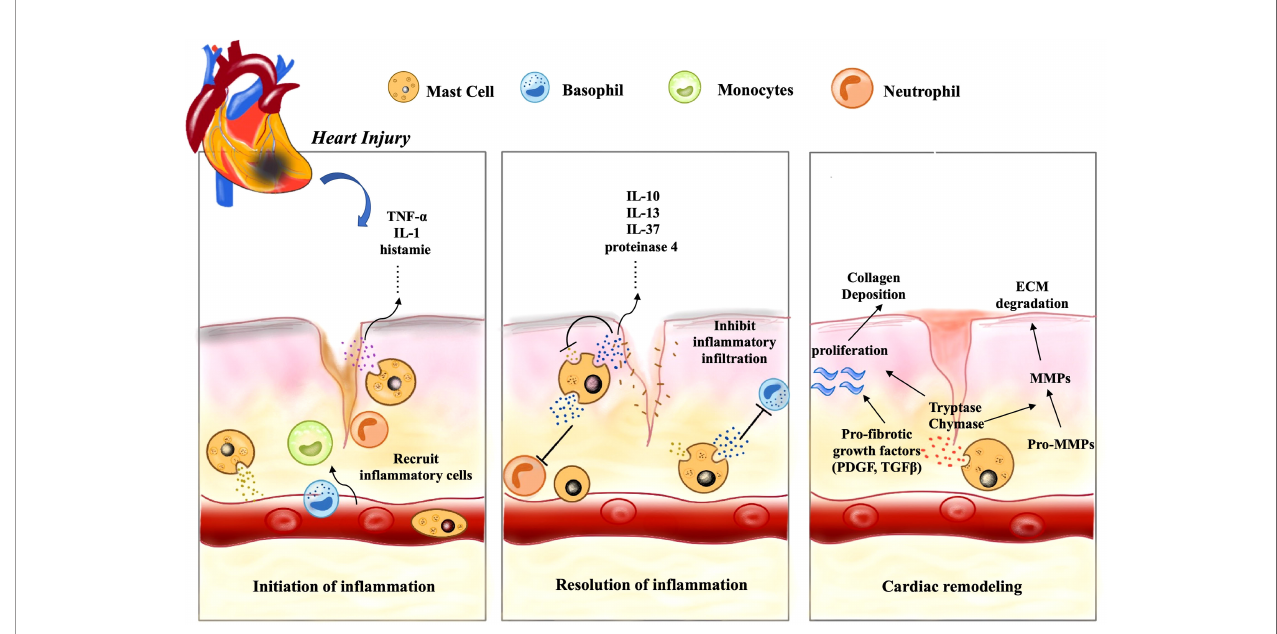
FIGURE 3 | CMCs play an important role in cardiac remodeling following injury. Following cardiac injury, fi rstly, CMCs are activated, release a large number of in fl ammatory mediators, such as histamine, TNF- a and IL-1 to change vascular permeability, recruit a lot of in fl ammatory cells (basophils, monocytes, neutrophils, etc.), and induce early in fl ammation. Secondly, CMCs also mediate the in fl ammatory resolution by secreting some anti-in fl ammatory factors such as IL-10, IL-13 and IL-37. Finally, a series of pro- fi brotic and anti- fi brotic effects coexist and lead to cardiac